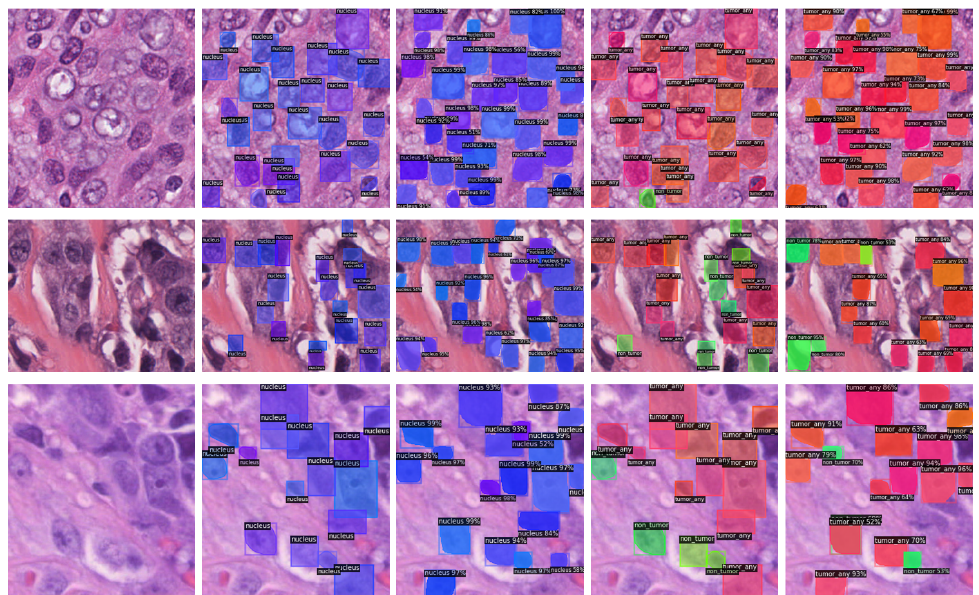
Figure 5. Internal validation. ( First Column ) Original images. ( Second Column ) Ground truth for the D1C approach. ( Third Column ) Model predictions for the D1C approach. ( Fourth Column ) Ground truth for the D2C approach. ( Fifth Column ) Model predictions for the D2C approach. For the D1C approach, blue represents the nucleus class; for the D2C approach, green and red represent the non-tumor nucleus and tumor nucleus classes, respectively.